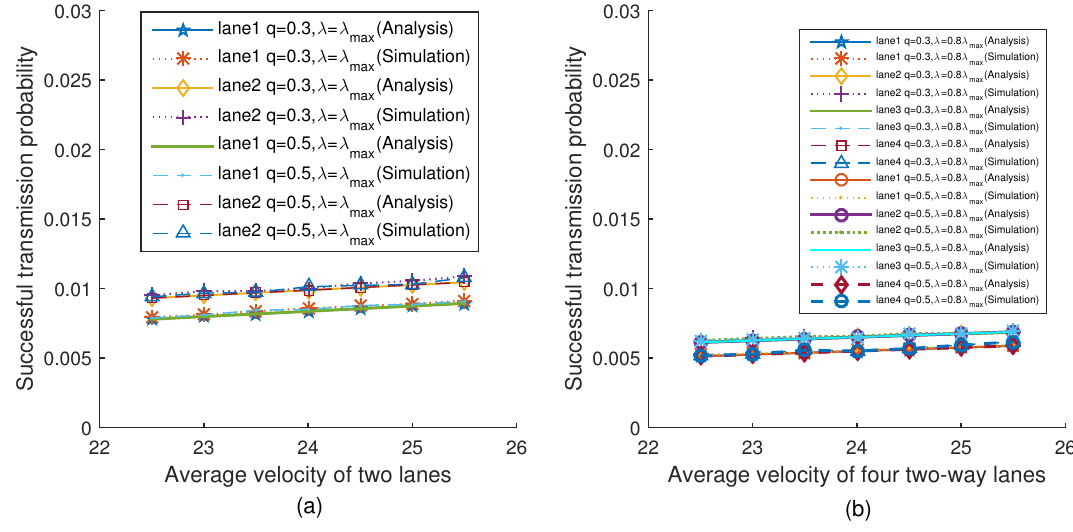
Figure 12. Successful transmission probability versus